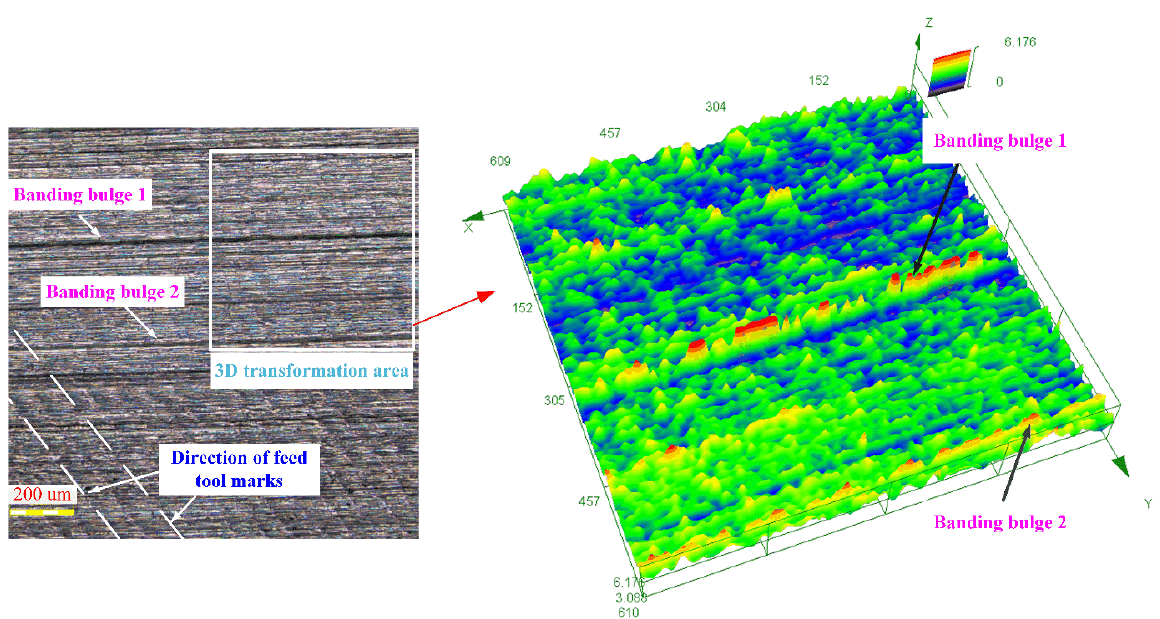
Figure 4. Feeding tool marks and surface scratches: ( a ) two-dimensional topography; ( b ) three-dimensional topography.